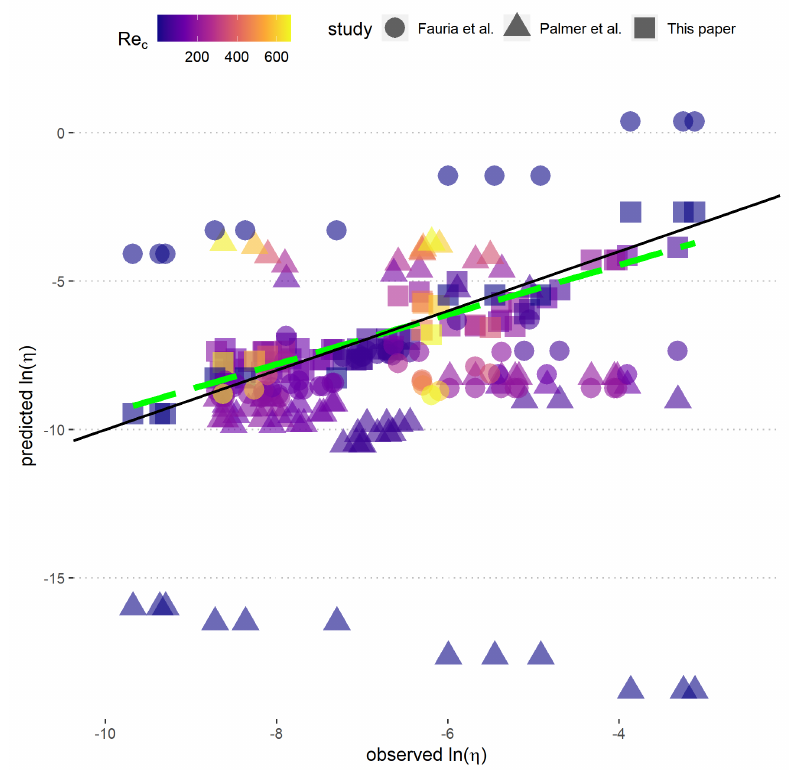
Figure 3. Observed ln( η ) for all data points compared with ln( η ) predicted by the models presented in Palmer et al. [35], Fauria et al. [34], and here. The solid black line is a 1:1 line; the dashed green line is the regression line of observed ln( η ) values vs. ln( η ) values predicted by the proposed